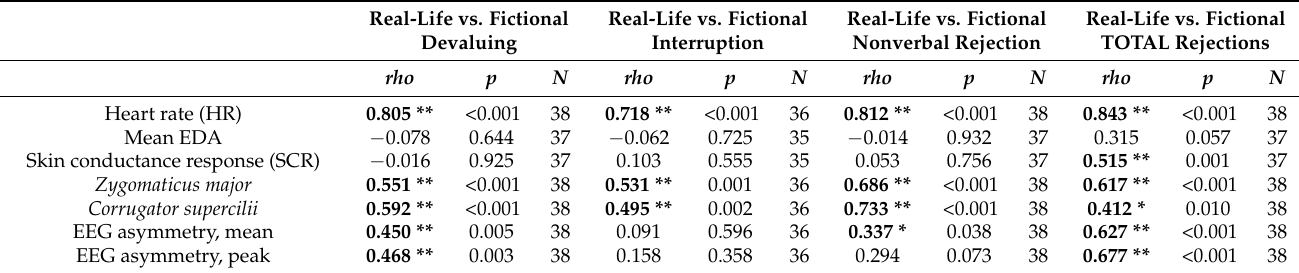
Table 3. Spearman’s Rank Correlations for Physiological Responses Between Real-Life and Fictional Social Rejections.